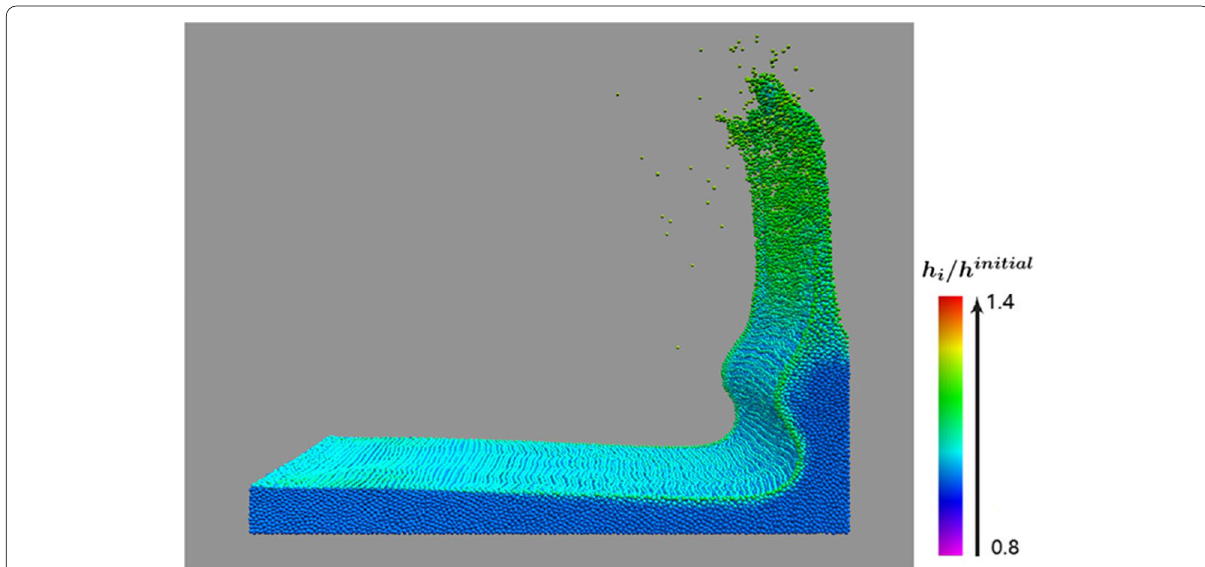
Fig. 2 Simulation of a 3D dam-break scene using VSLSPH (131328 particles), where the smoothing lengths of particles are shown by different colors, ranging from purple to red